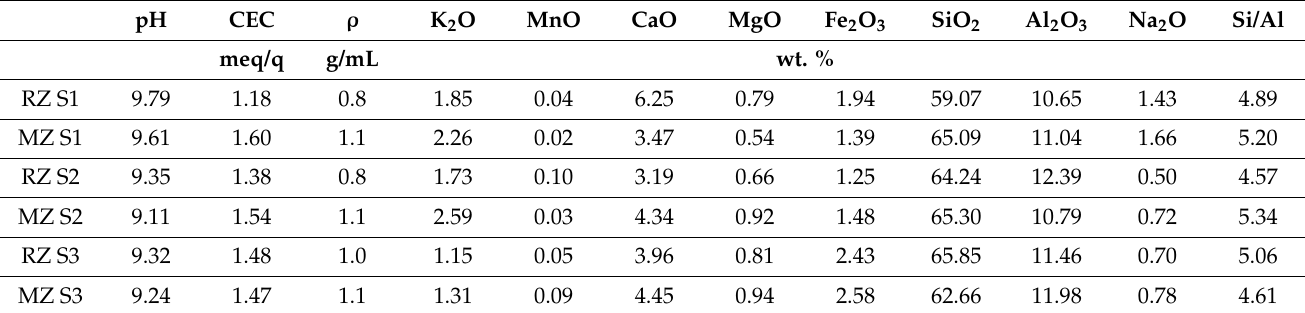
Table 1. Physicochemical properties of RZ and MZ